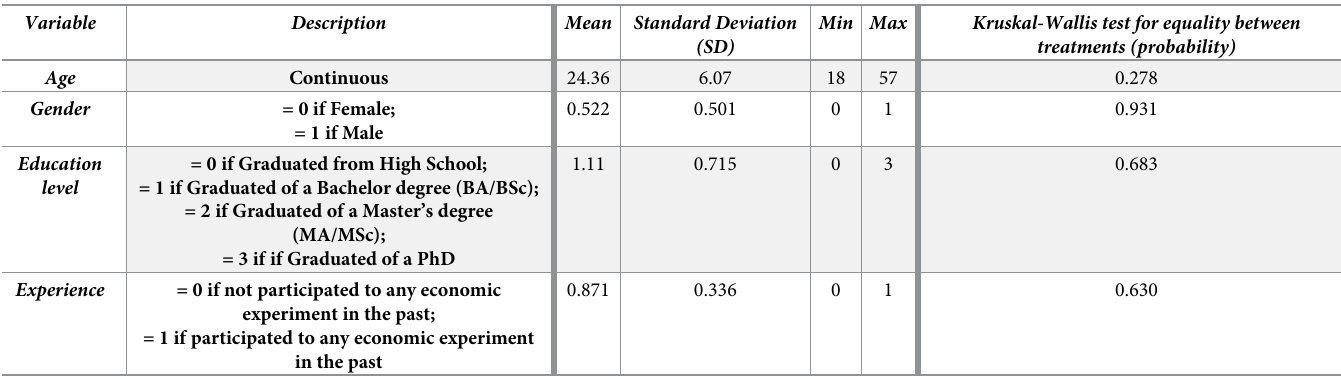
Table 1. Socio-economic characteristics of the sample ( n =